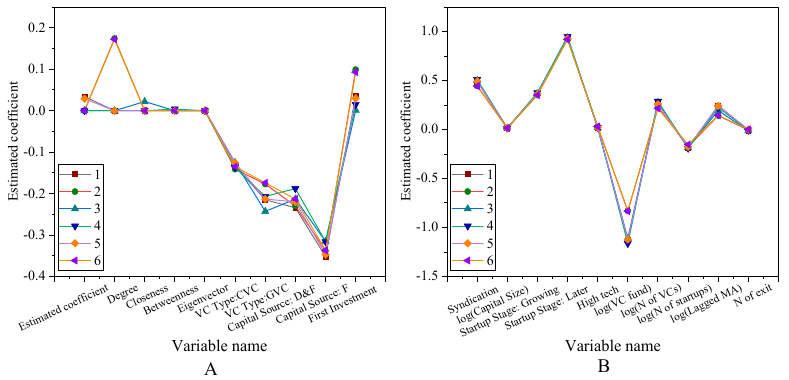
Figure 8. Impact of venture capital social networks on entrepreneurial performance ( A ) Top 10 variables ( B ) Other variables.